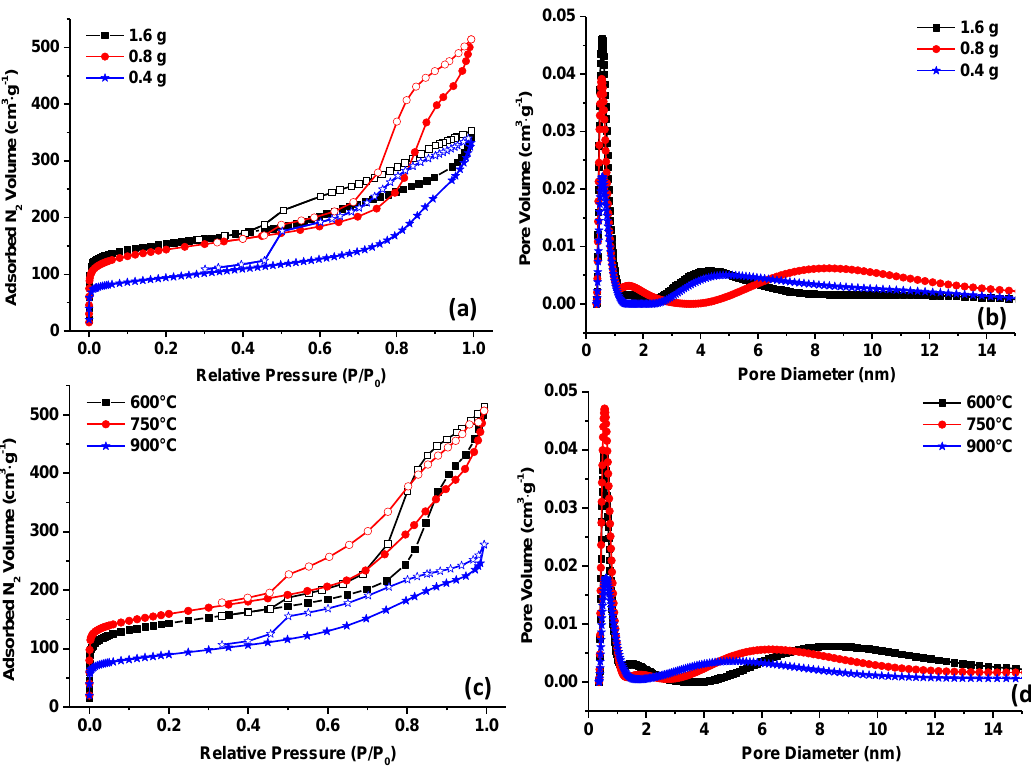
Figure 5. Nitrogen adsorption/desorption isotherms and the corresponding 2D-NLDFT pore size distribution of carbon materials obtained by using the stirring procedure and different amounts of template ( a , b ) and different temperatures (template amount 0.8 g) ( c , d ).